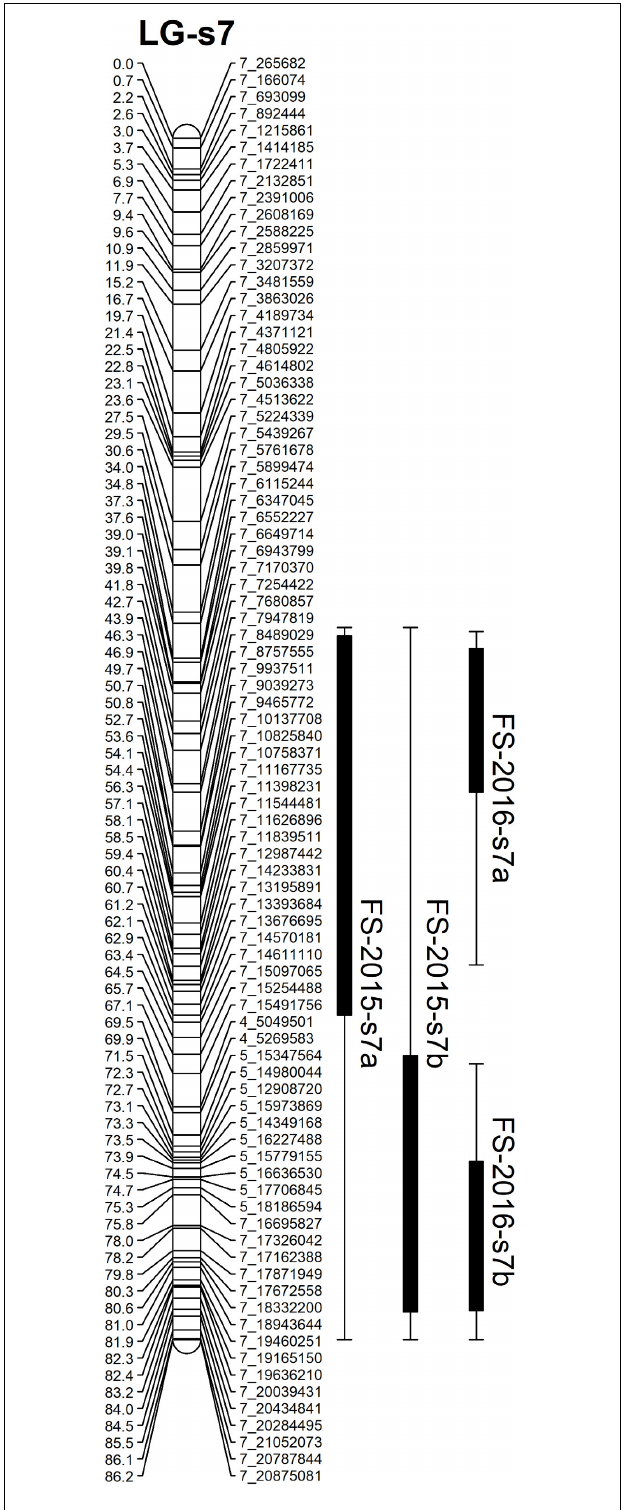
FIGURE 6 | Mapping QTLs with foliar symptoms and canopy damage on the sweet orange genetic linkage map. Thick bars on the right side of each LG indicate confidence interval of QTLs with LOD score above threshold and flanking error bars indicate extension of QTL region at LOD score 2.0.